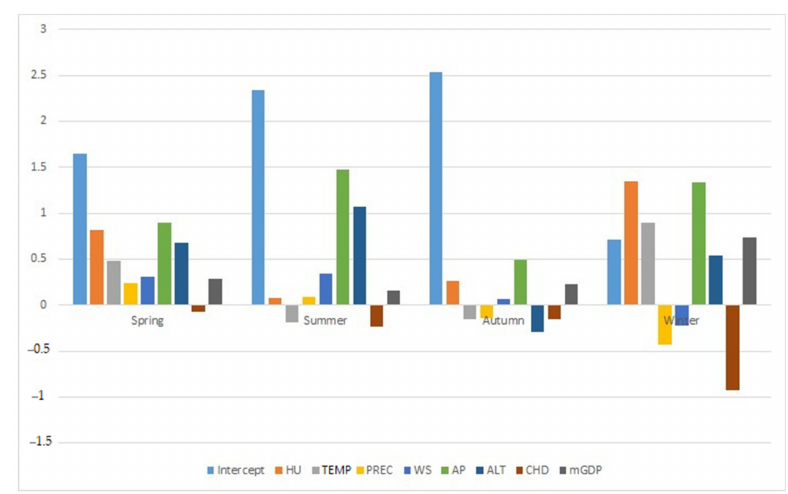
Figure 3. Average coefficients of the potential risk factors in the four seasons.